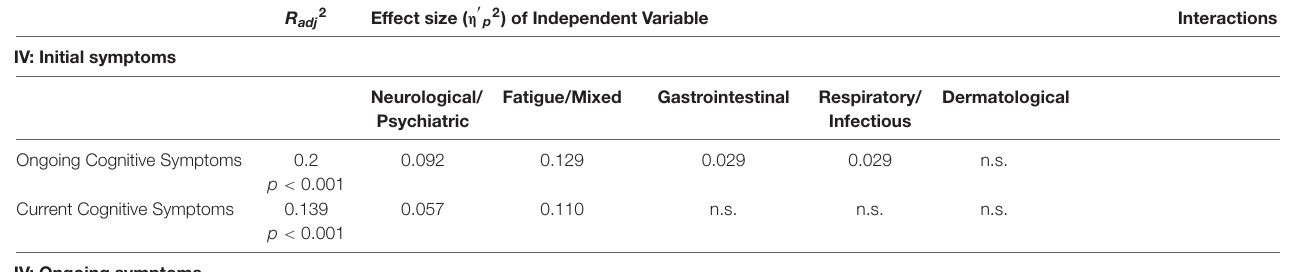
TABLE 5 | Regression models predicting variation in the cognitive symptom factor (ongoing and current) from non-cognitive symptom factors (initial, ongoing, and current). R adj 2 Effect size ( η (cid:48) p 2 ) of Independent